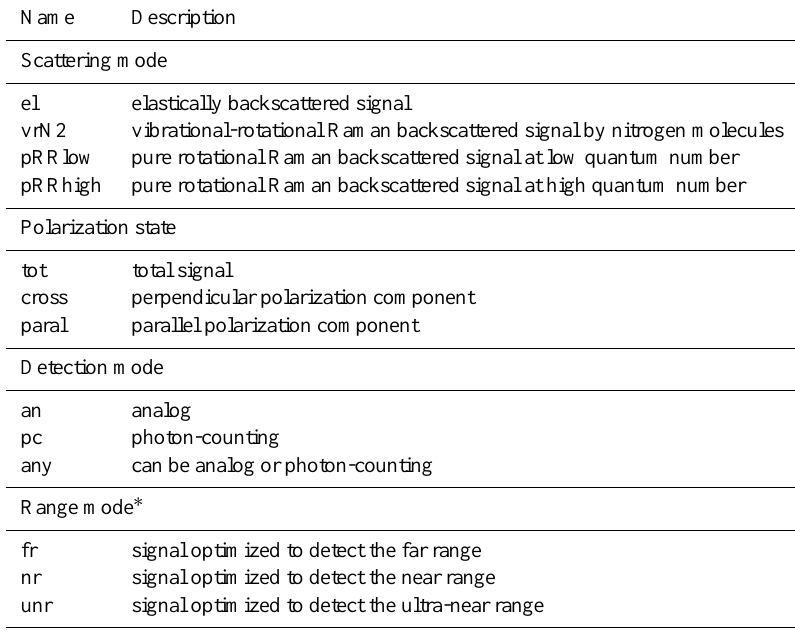
Table A1. Nomenclature used to identify univocally the different types of lidar signals detected by all EARLINET lidar